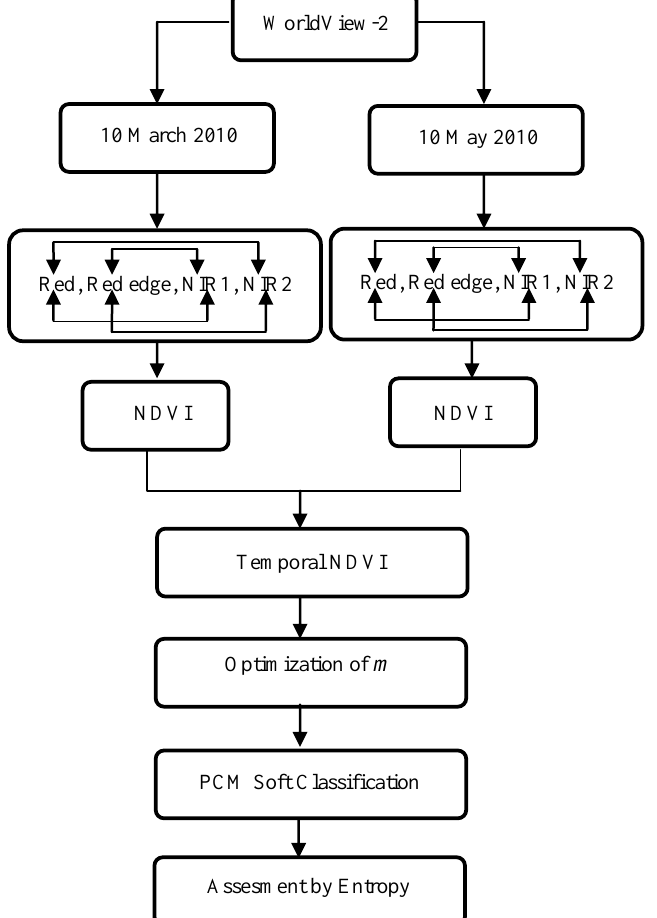
Figure 3: Optimization of weighting exponent ( m ) for spectral